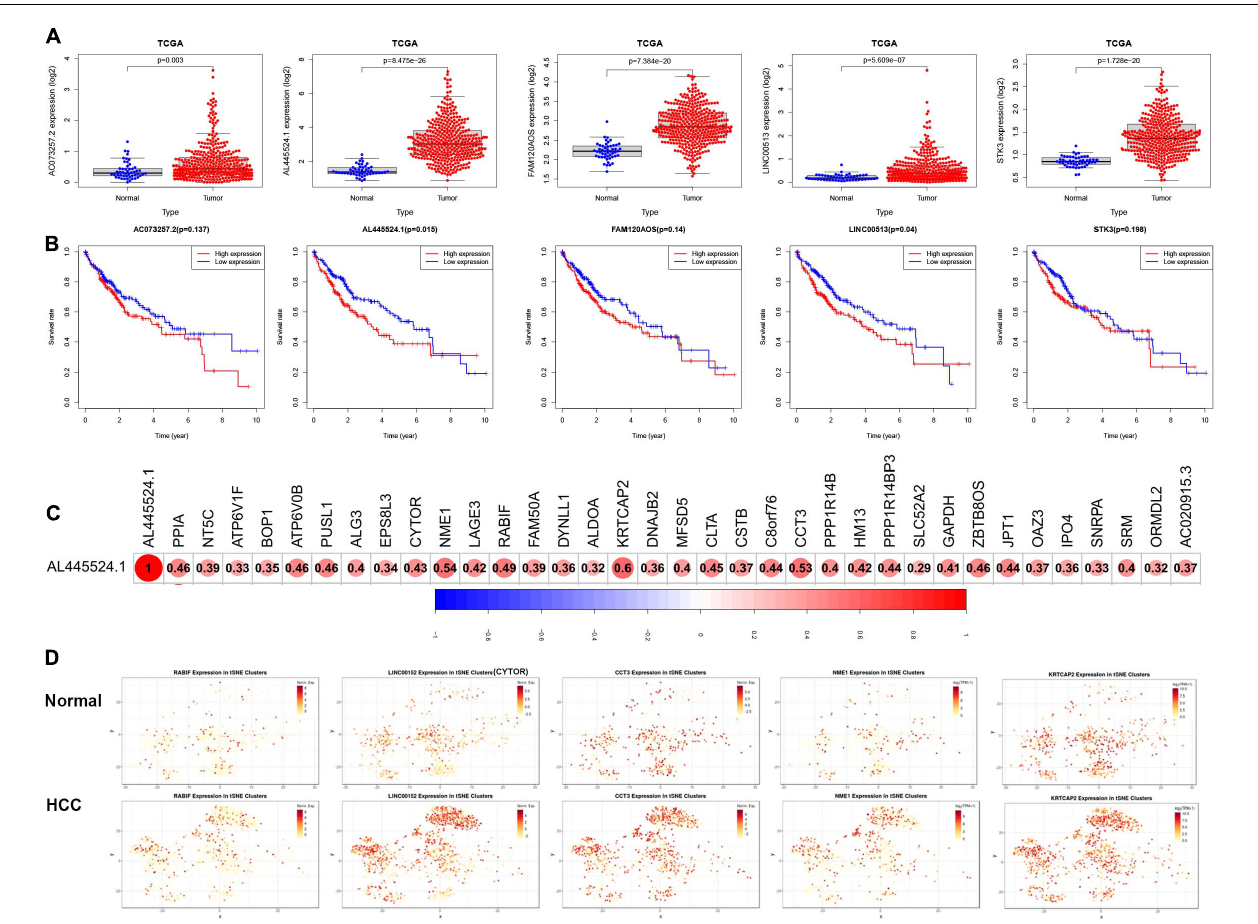
FIGURE 7 | The expression of 5 modeled risk eRNAs and associated genes in HCC prognosis. (A) Risk eRNAs are differentially expressed between TCGA normal and HCC tissues. (B) Survival curves analyzed the role between high and low expression of risk eRNA. (C) AL445524.1 is positively associated with 35 genes. (D) The tSNE analysis of AL445524.1 associated five